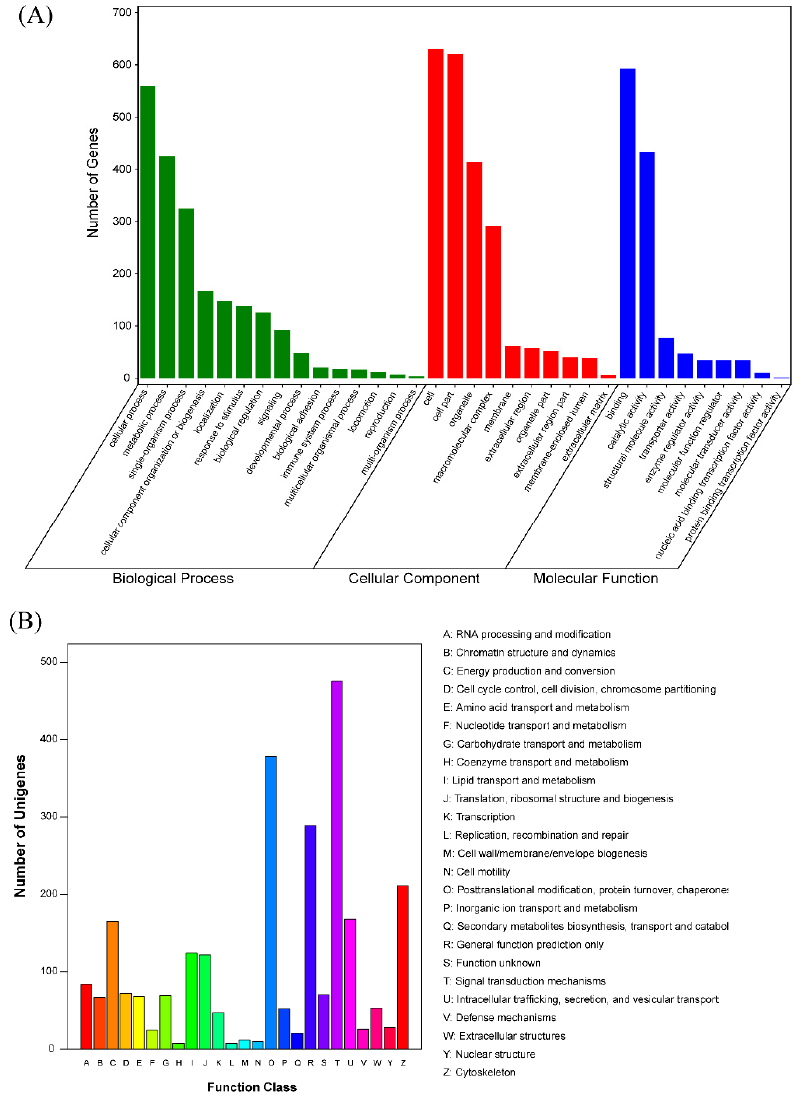
Figure 1. GO and KOG annotation and classification of all identified proteins. ( A ) GO classification of all the proteins identified. x axis represents the GO terms in three types of GO ontology, and the y axis represents the gene number. ( B ) KOG classification of all proteins identified. x axis refers to function class; y axis represents the gene number.